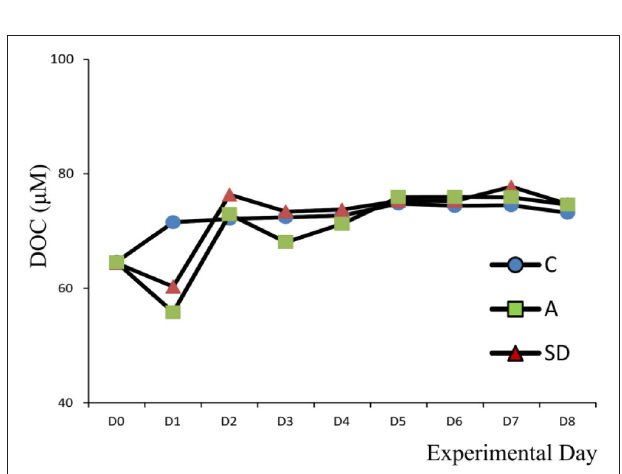
FIGURE 2 | Dissolved organic carbon (DOC) concentration in the different